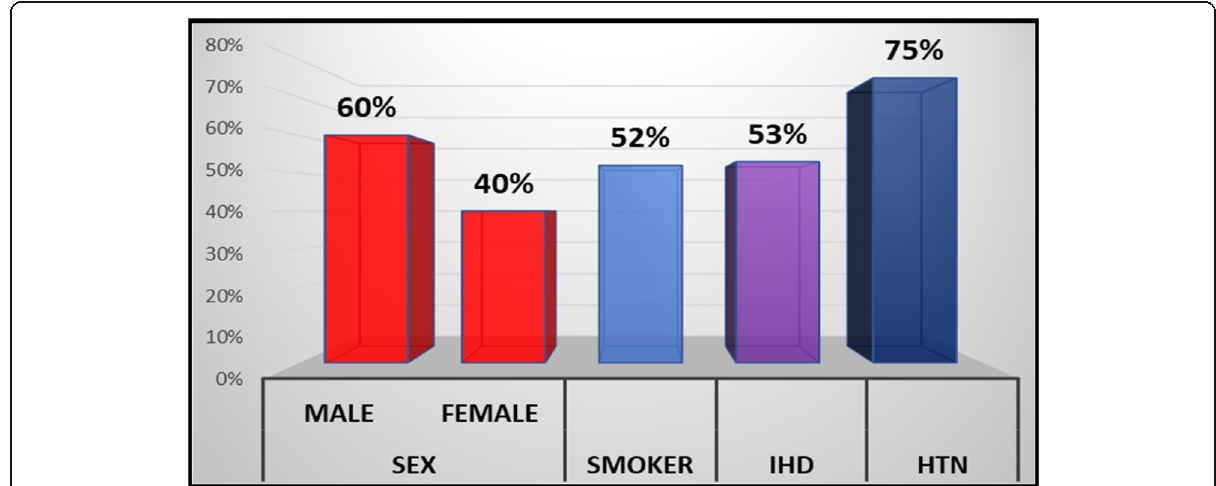
Fig. 1 Basic data of cerebrovascular stroke